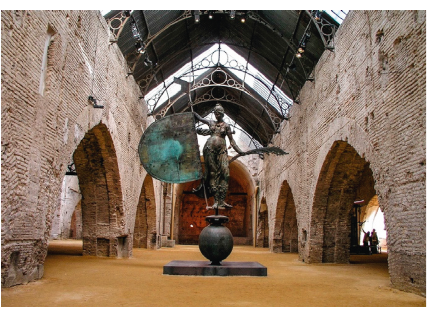
Figure 1: Reales Atarazanas de Sevilla (Seville Royal Dockyards).